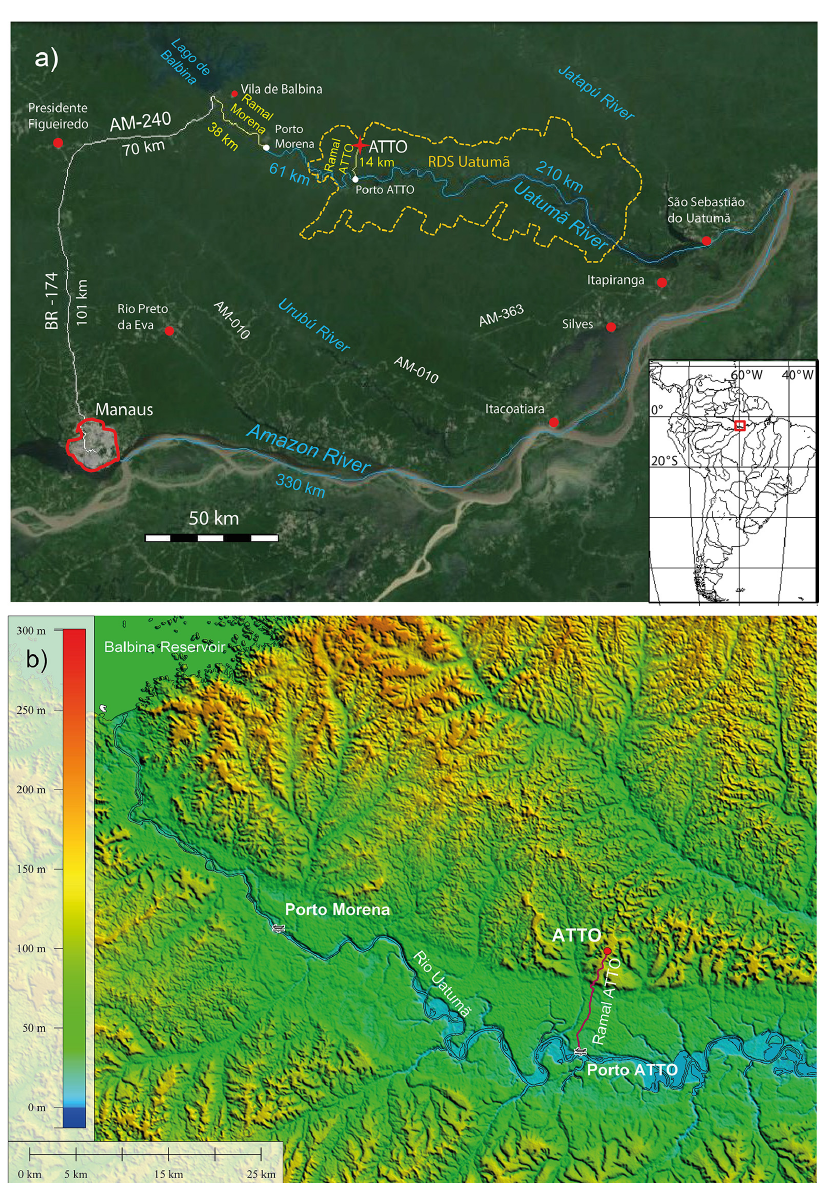
Figure 1. (a) Location of the ATTO site. The main map shows the access to the site via the road and riverboat connections (background map from Google Earth). (b) Topography in the region around the ATTO site. The Balbina Reservoir is in the northwestern corner of the